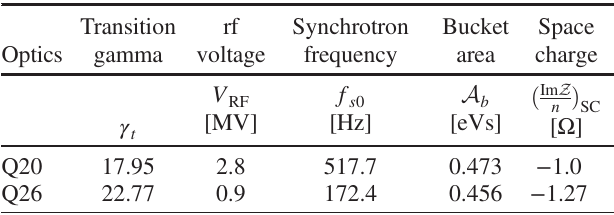
TABLE I. The SPS beam and machine parameters for the two different SPS optics at 26 GeV =